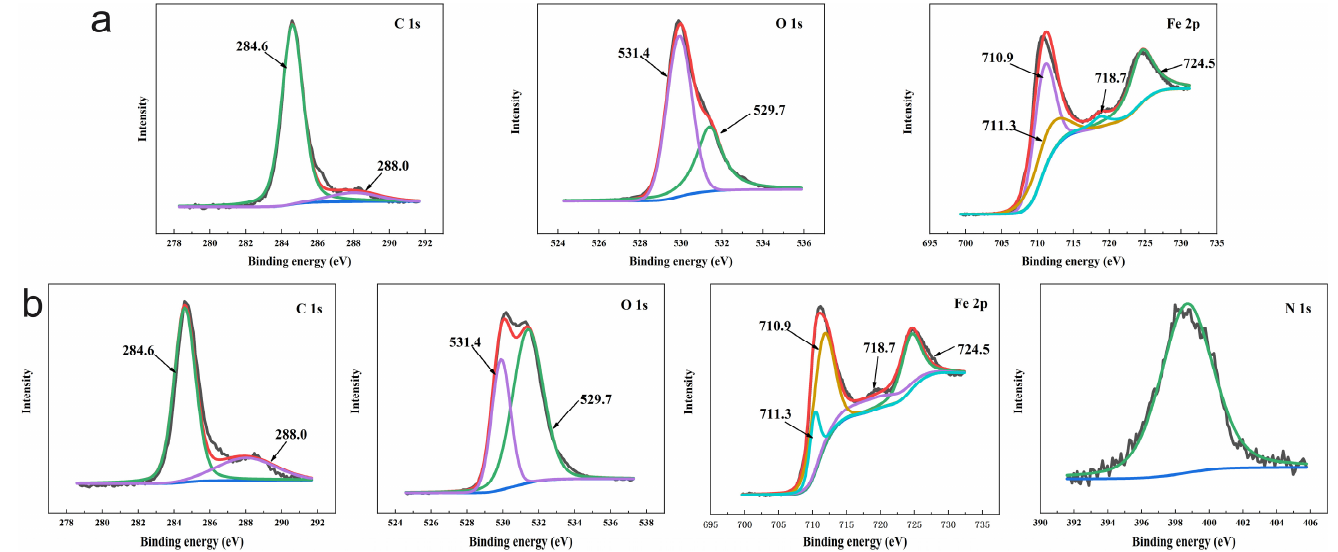
Figure 8. XPS results after immersion of casing steel in residual acid solution with or without Mb inhibitor at 90 °C for 4 h: ( a ) pH 3.0; ( b ) pH 3.0 + Mb.